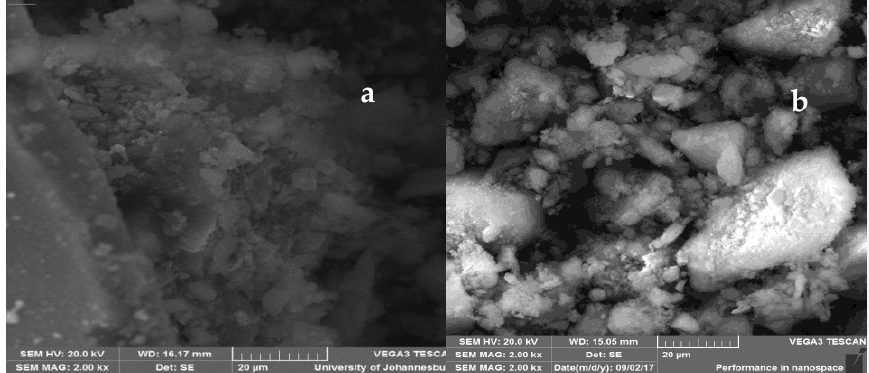
Figure 2. SEM images of ( a ) Fe 2 O 3 -SiO 2 ( b ) Fe 2 O 3 -SiO 2 -PAN.